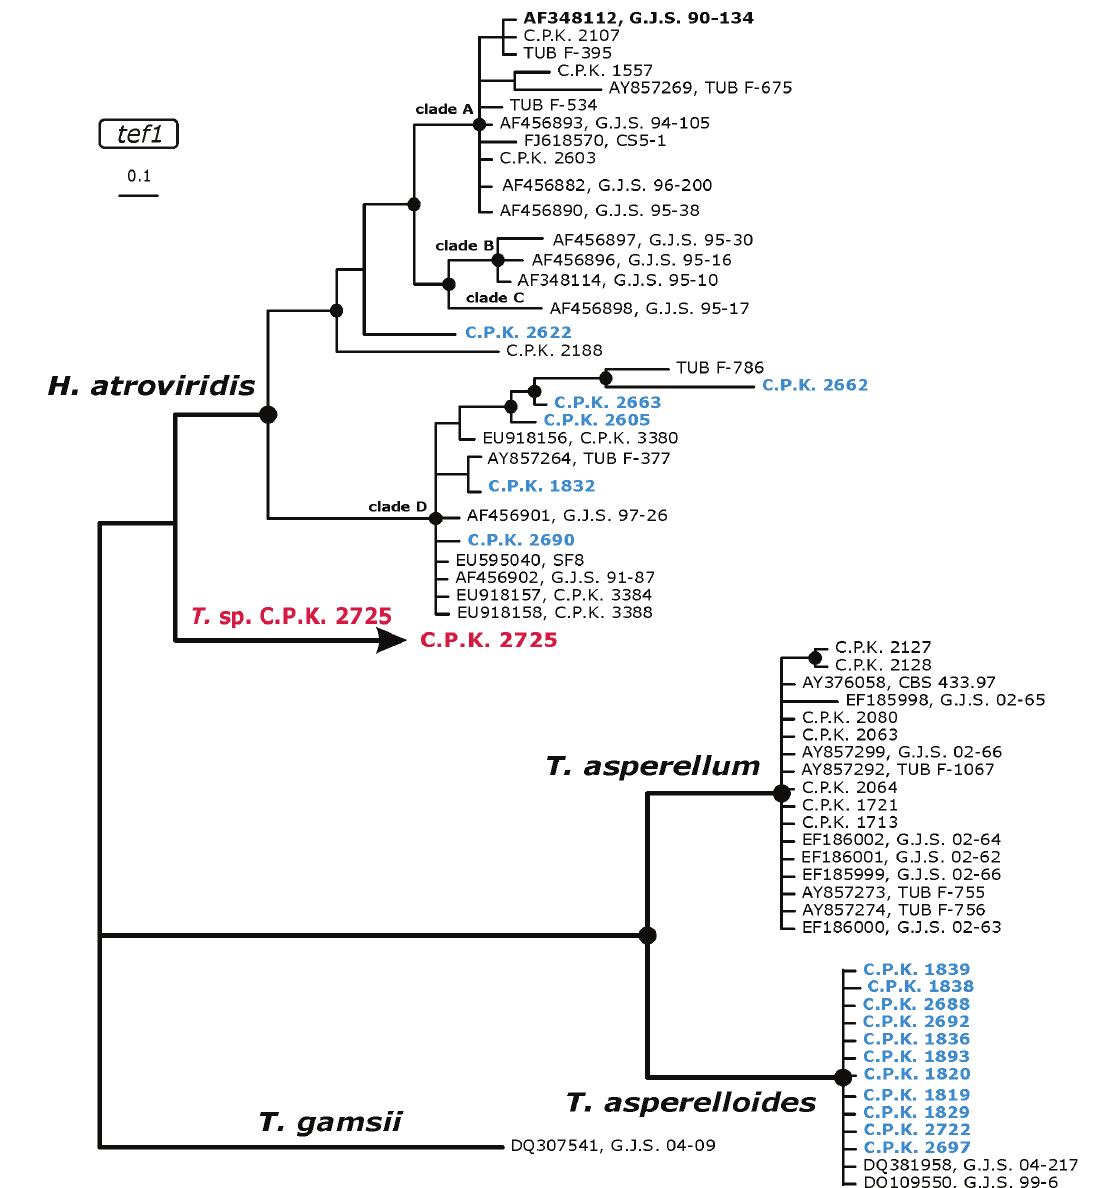
Figure 2. Identification phylogram of Trichoderma diversity from rhizosphere of C . arabica in a vicinity of H . atroviridis/T . atroviride and T . asperellum inferred from a Bayesian analysis of tef1 intron alignments. The position of the potentially new species is shown in red, while hypothetically endemic populations of known species are marked by blue. Nodes with black circles indicate posterior probabilities >0.94. All reference strains are given by the accession number of the corresponding tef1 sequence in GenBank and/or strain number. Infraspecific groups and species names are given above branches leading to the corresponding